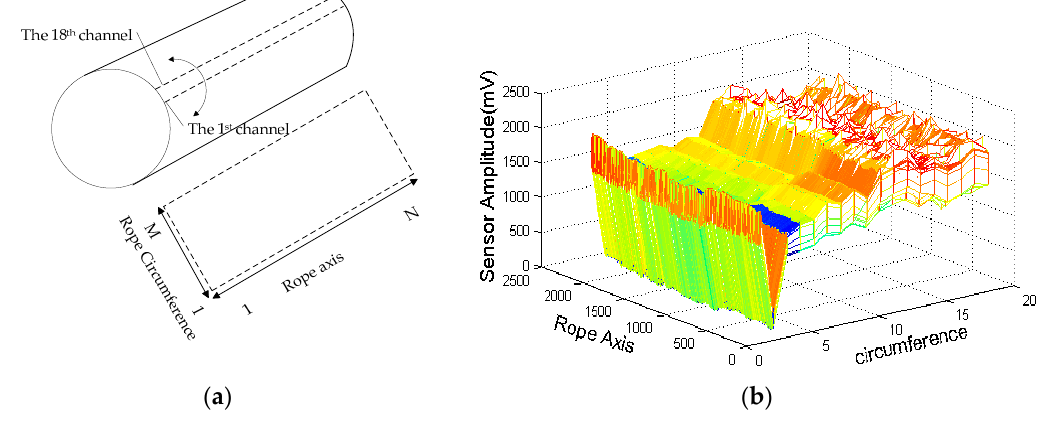
Figure 2. ( a ) Unrolled detection surface; ( b ) Raw data rolling image.